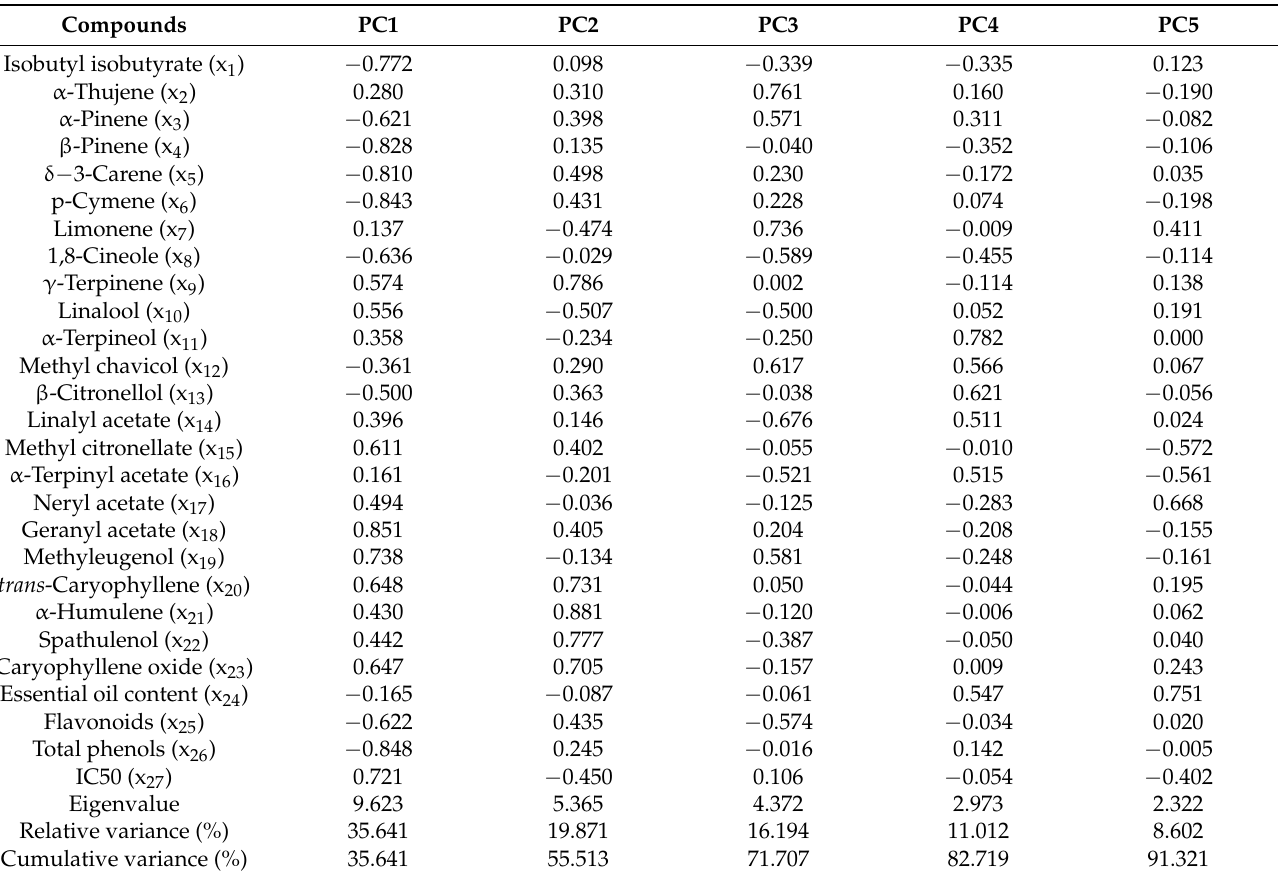
Table 3. Principal component analysis of phytochemical compounds of myrtle organs in different phenological